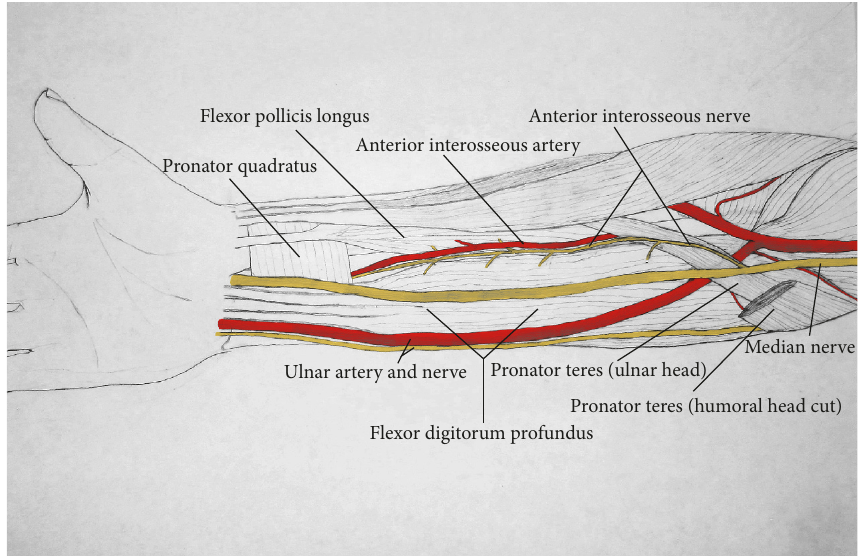
Figure 1: Rendition of forearm anatomy ∼ drawn by Jeremiah